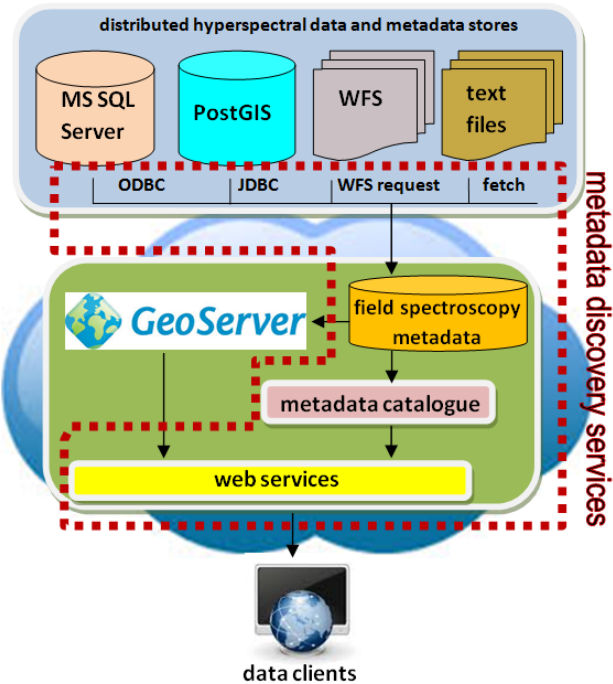
Figure 1 A software architecture describing a metadata discovery service for field spectroscopy datasets